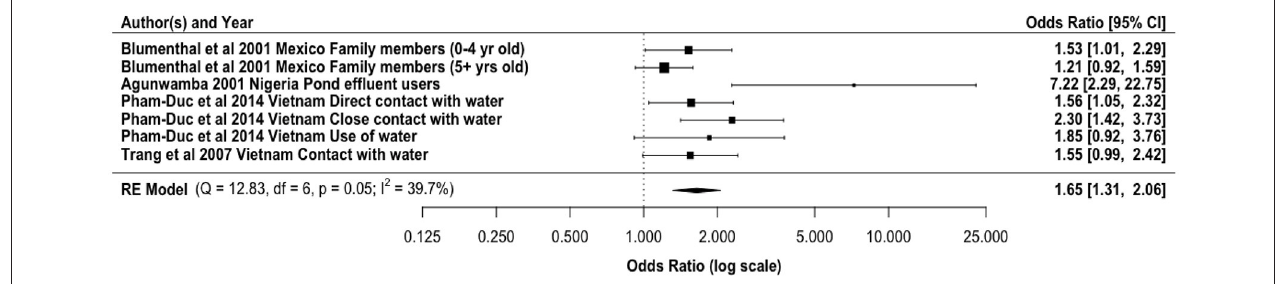
FIGURE 2 | Odds ratio for exposure to partially treated and untreated wastewater and diarrheal disease incidence from selected literature.